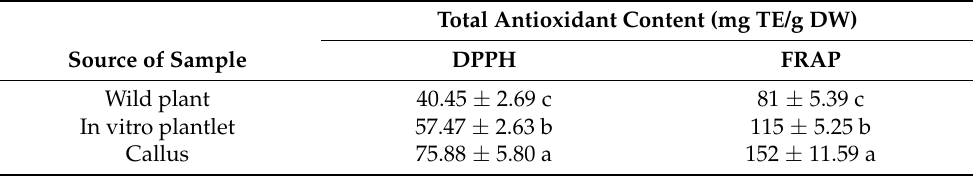
Table 6. Total antioxidant activities using DPPH and FRAP methods of different samples of Labisia pumila var. alata aqueous extract.